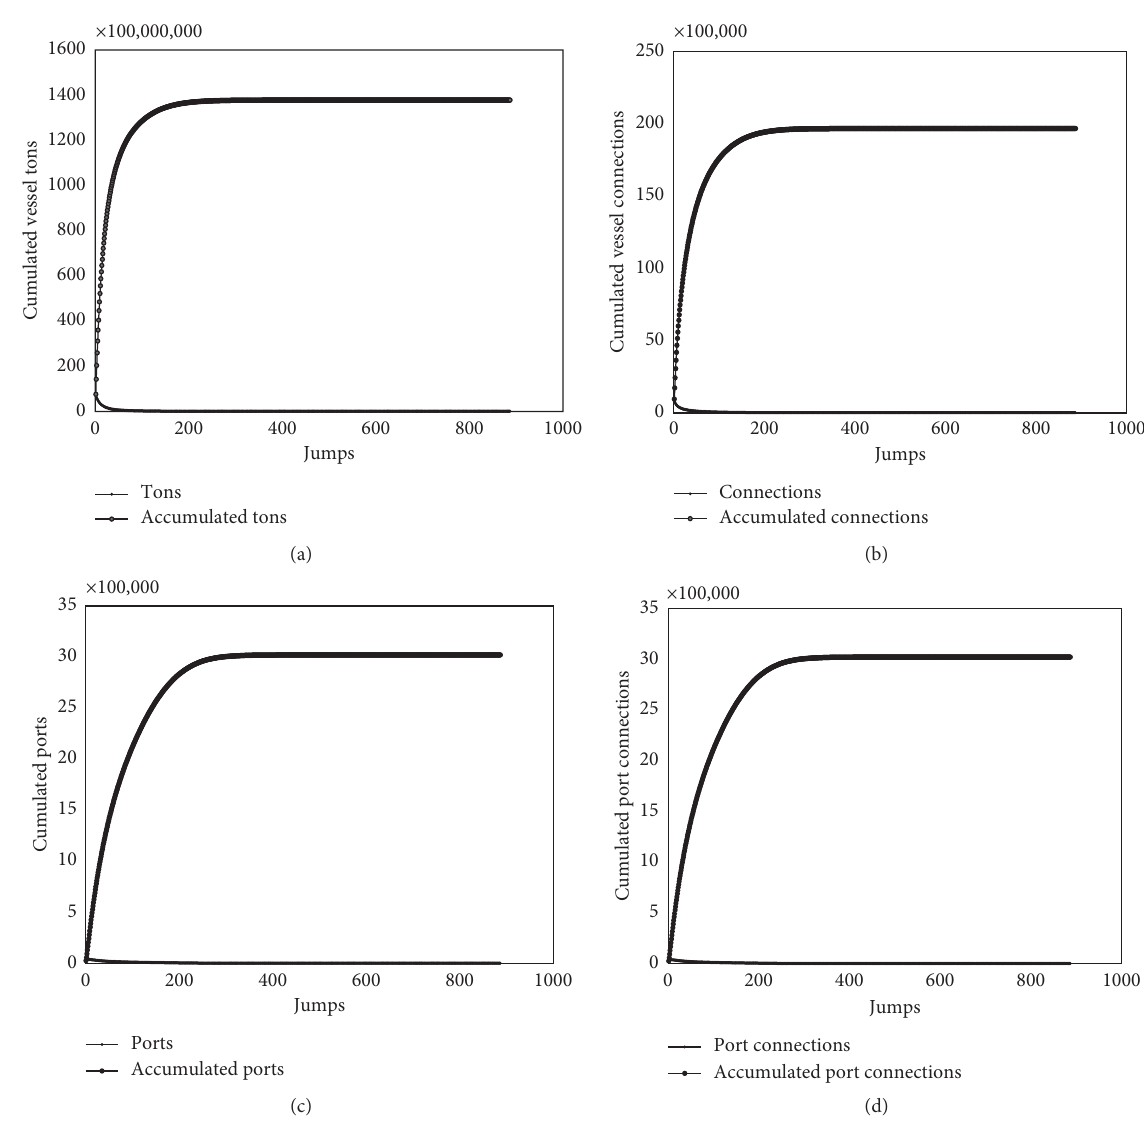
Figure 4: Japanese port distributions impacted by jumps. (a) F weight |